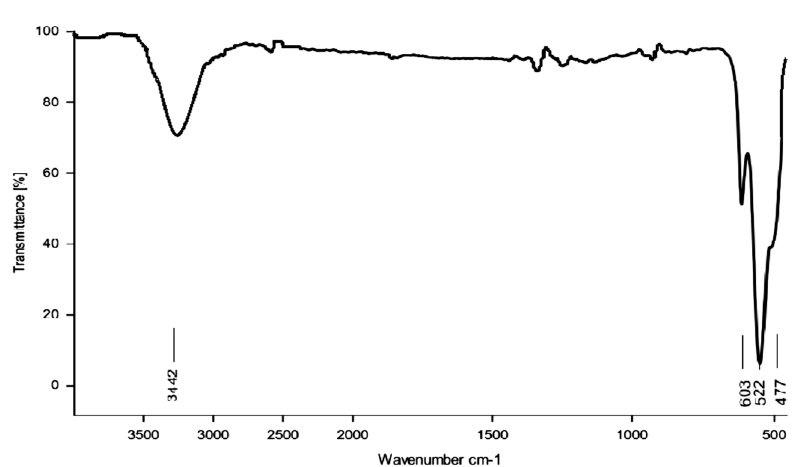
Figure 3. FT-IR spectrum of CuO